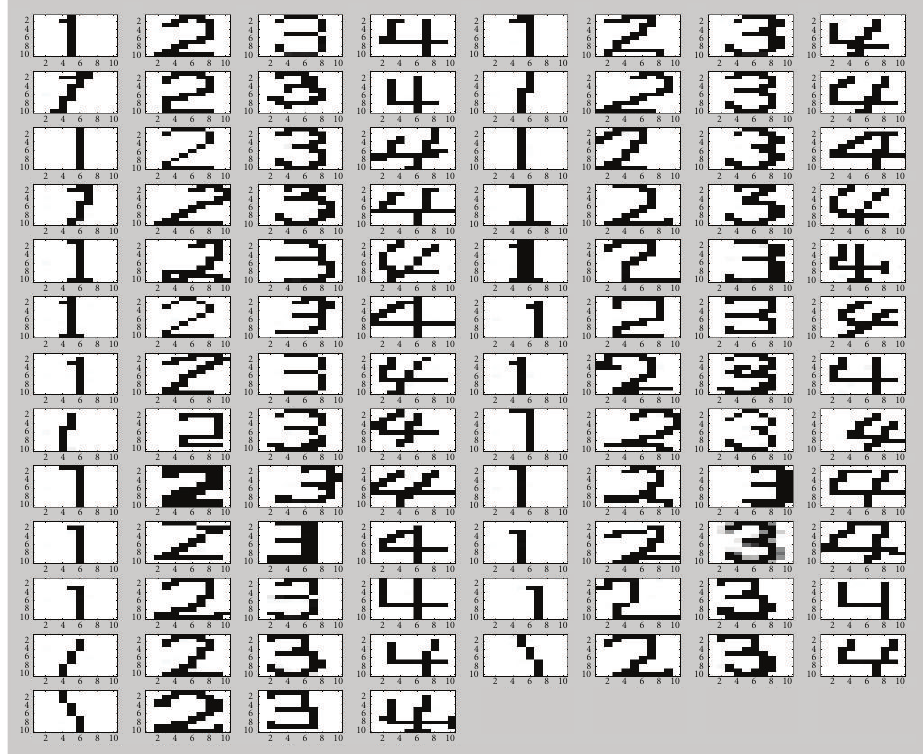
Figure 7: The picture of 100 di ff erent patterns of alphanumeric letters 1, 2, 3, and 4 used in the optical character recognition